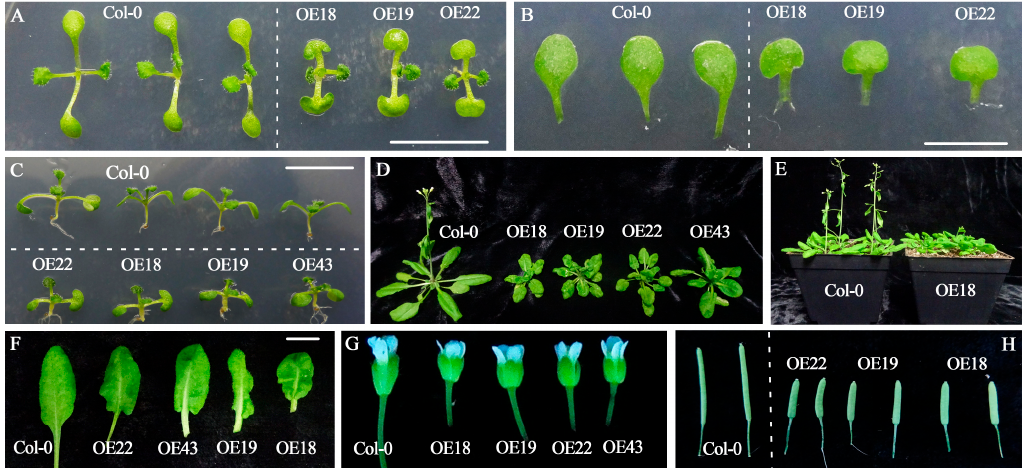
Figure 5. Phenotypic pictures of RsOFP2.3 ‐ overexpressing transgenic plants and the wild type (WT). ( A ) Top view of 7 ‐ day ‐ old seedlings in the T2 transgenic lines OE18, OE19, and OE22 and the WT. Bar = 1cm. ( B ) Close ‐ up view of cotyledons from 7 ‐ day ‐ old seedlings of the T2 transgenic lines and WT. Bar = 0.5 cm. ( C ) Lateral view of 7 ‐ day ‐ old seedlings of the T2 transgenic lines and WT for comparison of hypocotyls. Bar = 1 cm. ( D ) An overview of 26 ‐ day ‐ old seedlings of the T2 transgenic lines and WT. ( E ) Bolting and flowering in transgenic compared with WT plants. Both were delayed in the transgenic plants. ( F ) Fully developed rosette leaves of the WT and transgenic lines. Bar = 1 cm. ( G ) Floral organs of the WT and transgenic lines. ( H ) Siliques of the WT and transgenic lines.